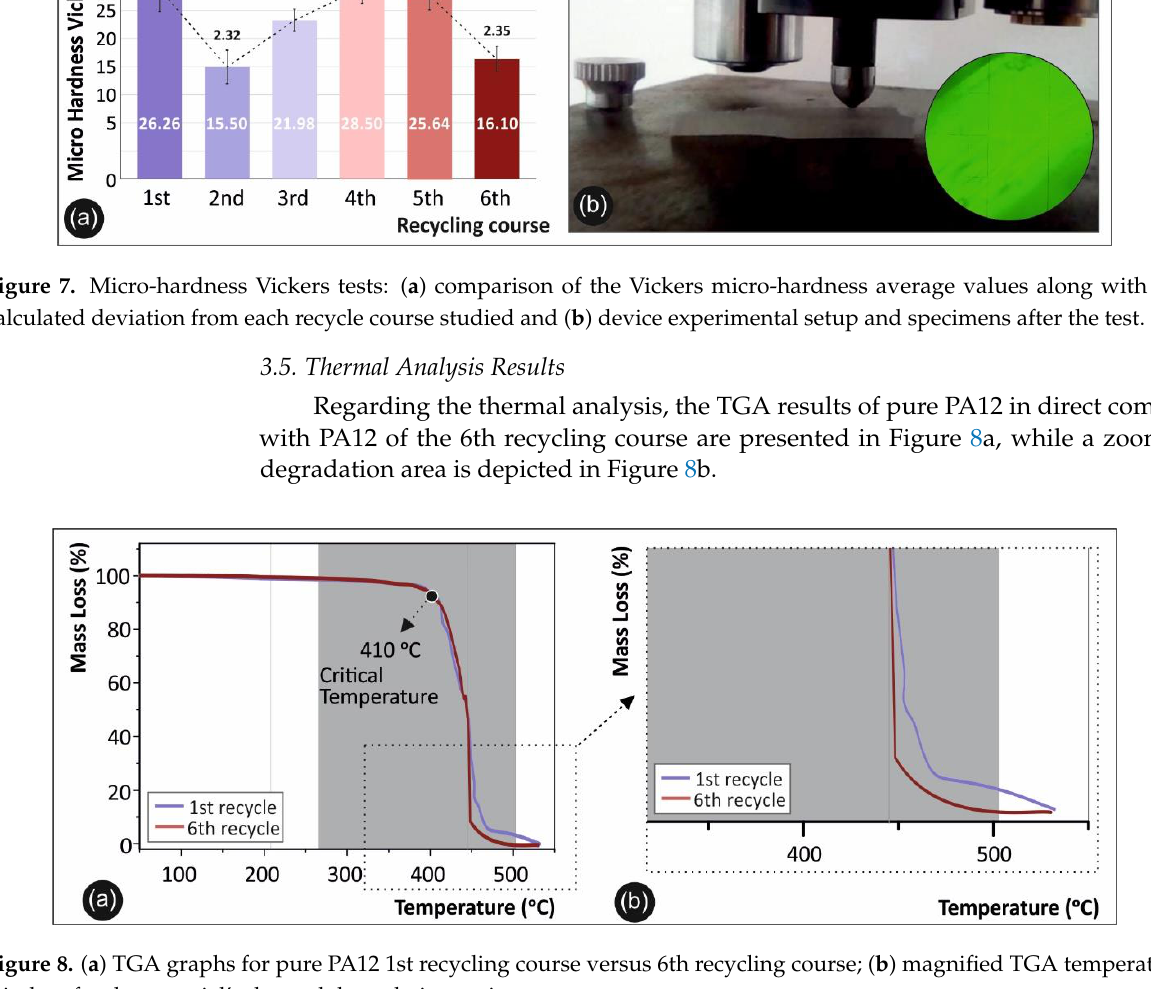
Figure 7. Micro-hardness Vickers tests: ( a ) comparison of the Vickers micro-hardness average values along with the cal- culated deviation from each recycle course studied and ( b ) device experimental setup and specimens after the test.